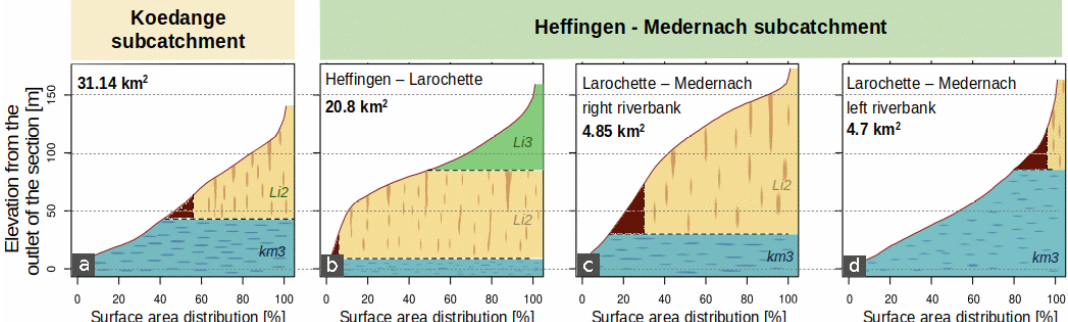
Figure 3. Geological profiles in the Ernz Blanche catchment. Elevation distribution of (a) the Koedange subcatchment, (b, c, d) 3 subsections of the Heffingen–Medernach area: (b) the Larochette – Heffingen subsection; (c) the right riverbank of the Medernach – Larochette subsec- tion; (d) the left riverbank of the Medernach – Larochette subsection. Elevation is counted from the minimum elevation of each section. The geological substrates are designed according to their proportion in each section. Blue: marls from middle Keuper (Km3); dark yellow: Luxembourg sandstone (Li2); green: Strassen marls (Li3), dark brown: conglomerates, marls and altered